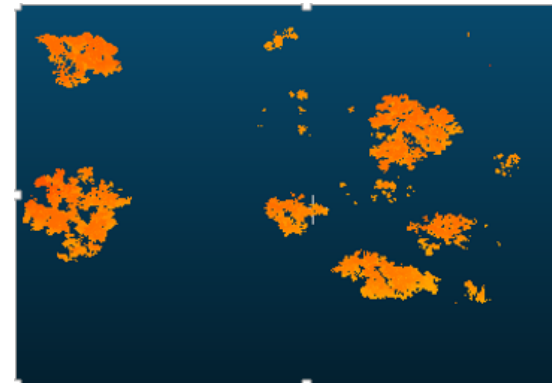
Figure7.The non-ground seed points in the measured area extracted by the CSF